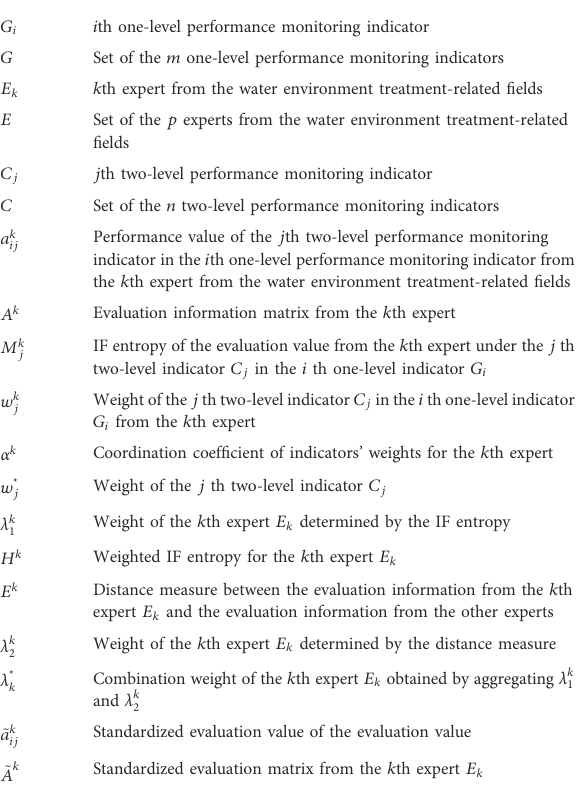
TABLE 1 Main symbols used in WETPs-PPP for the performance evaluation. Symbol Interpretation of